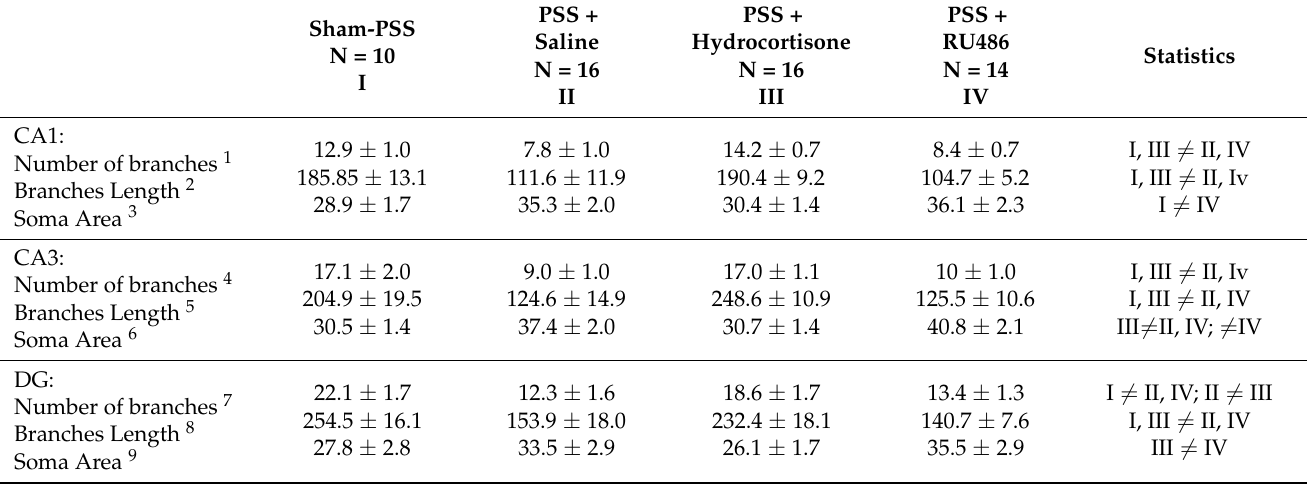
Table 2. Effects of high-dose hydrocortisone, saline or RU486 early post-exposure on Iba-1 positive cell counts in hippocampal subregions. Results displayed as mean ± S.E.M. NS = Not